Question: Based on the figure, does the quantity rise or fall?
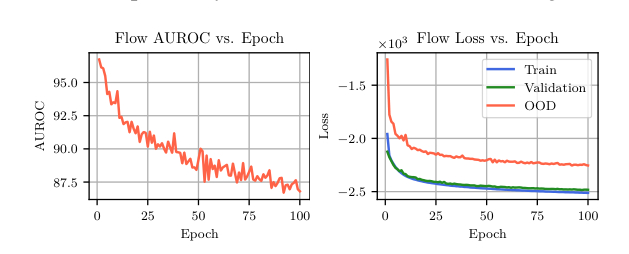
Answer: decreasing